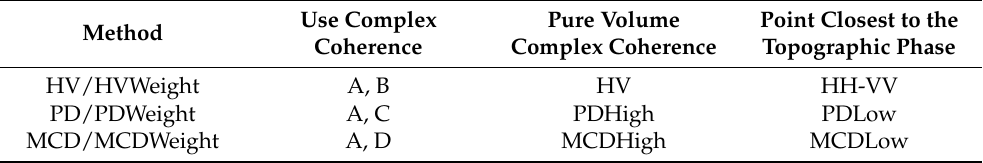
Table 1. Parameters corresponding to various